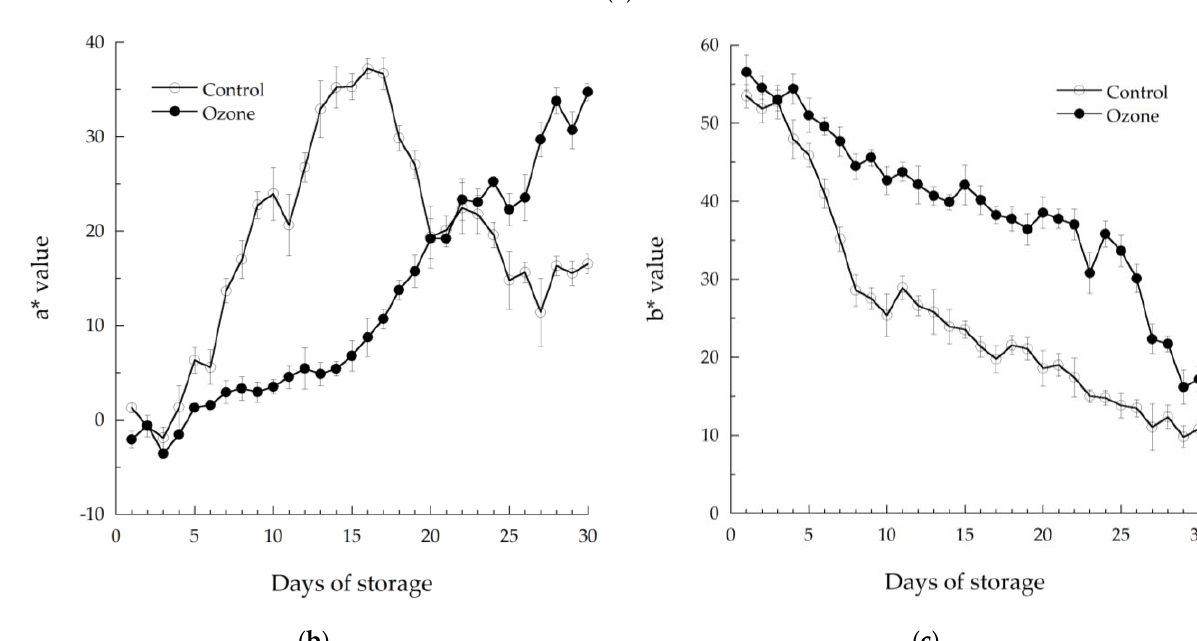
strates opposite characteristics, and the b* value will continuously decrease. Furthermore, Figure 5a – c demonstrates that these transformations happened more slowly in the treat- ment fruit. When the fruit color developed uniformly dark purple, the storage life ended. After the fruit color developed to uniformly dark purple was evaluated the quality in terms of their weight loss percentage, pericarp firmness, and sensory evaluation in terms of fruit pericarp color, flavor, and overall acceptability by ten trained panelists using a five-point